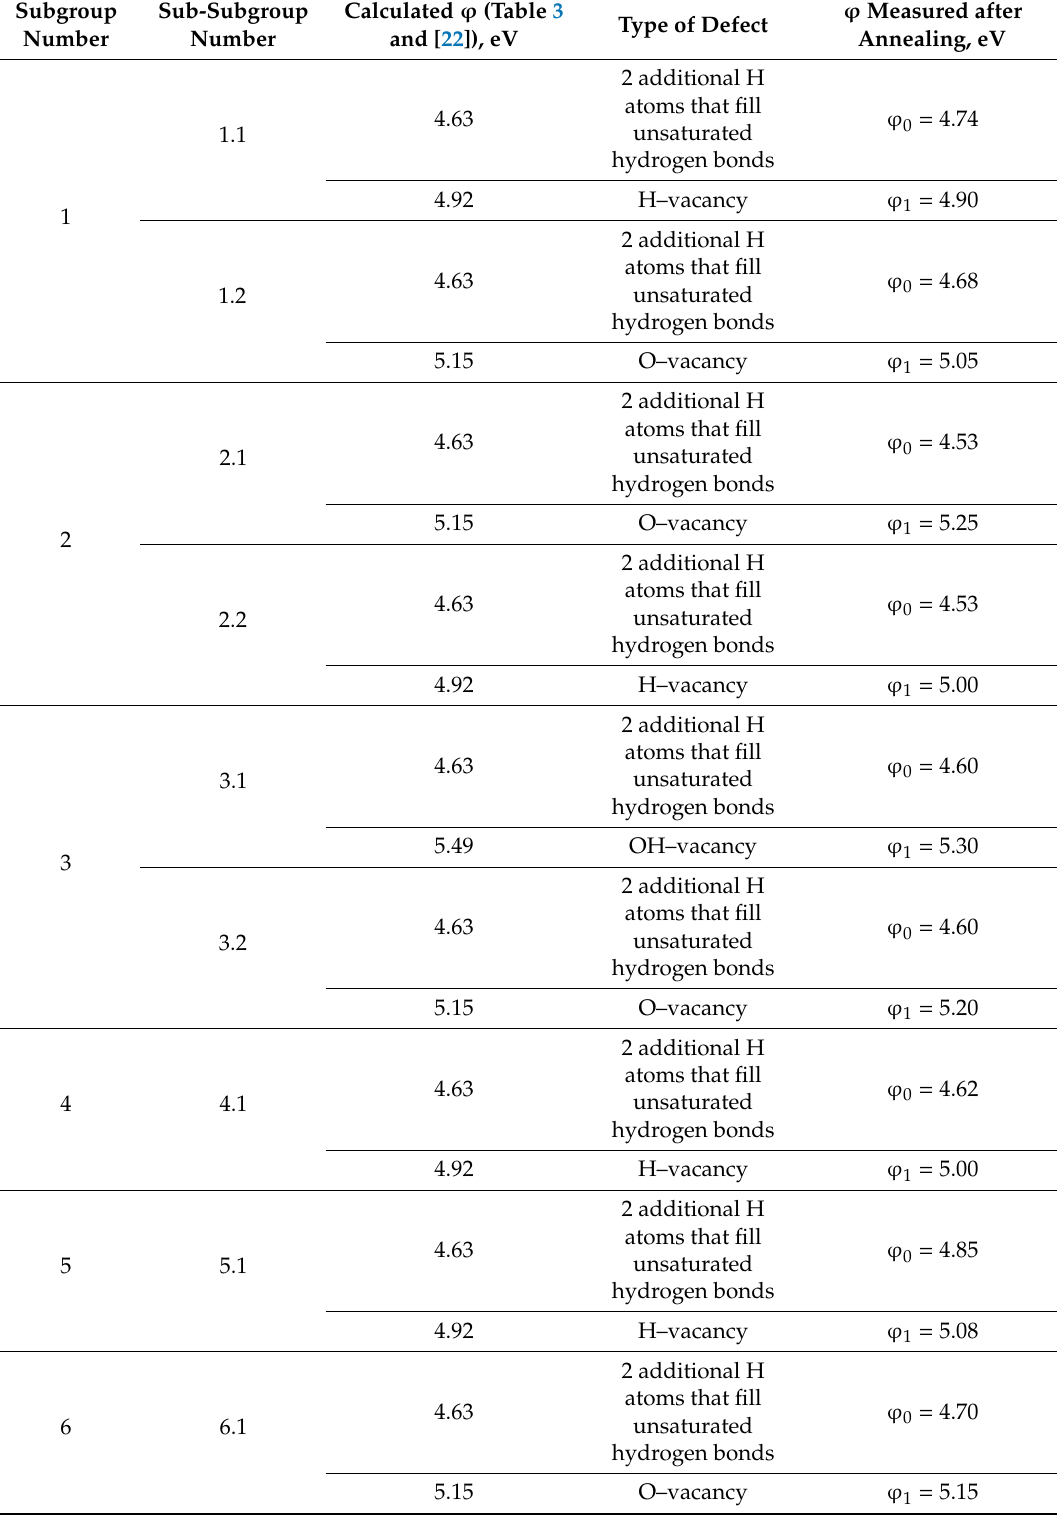
Table 8. Sub-subgrouping of the samples of the group